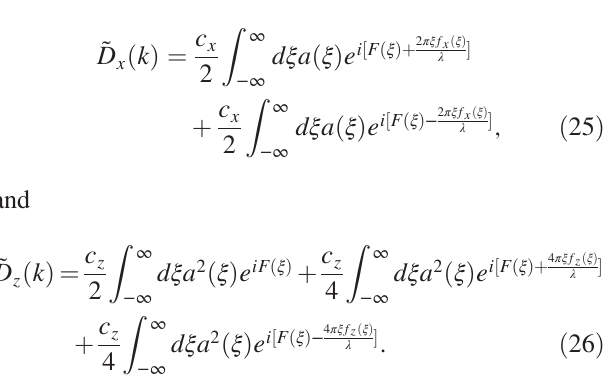
> E are nonphysical e T